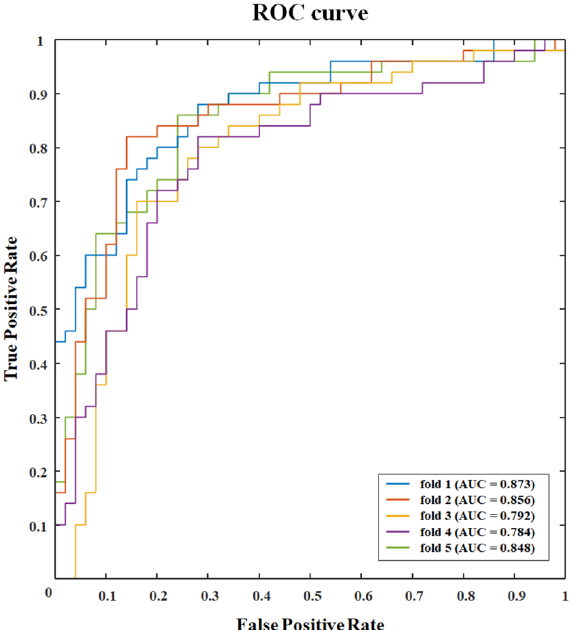
Figure 6. ROC curves for each fold in the classification using RBF-kernel SVM classifier with eleven microstate features selected by recursive feature elimination show a mean AUC of 0.831.The AUCs for each fold are as follows: 0.873, 0.856, 0.792, 0.784, and 0.848. ROC receiver operating characteristics, RBF radial basis function, SVM support vector machine, RFE recursive feature elimination, AUC area under the